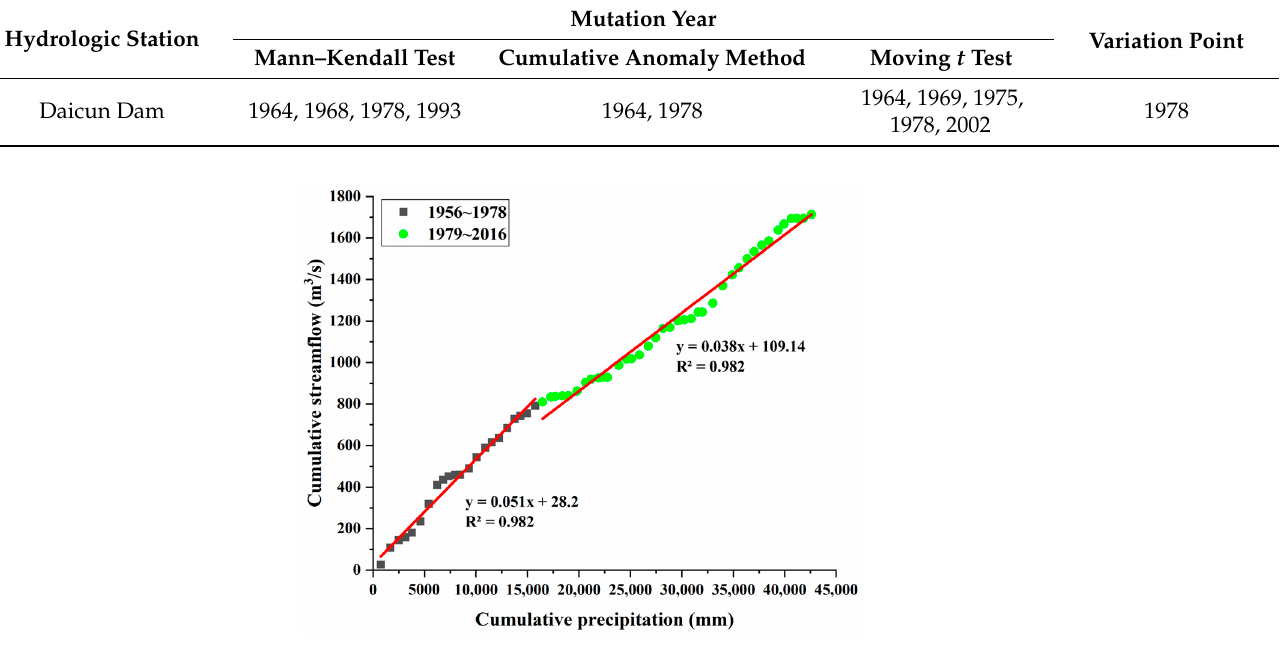
Figure 4. Precipitation–streamflow double-accumulative curve at Daicun Dam Hydrological Sta- tion. Table 2. Result of the mutation test of annual measured runoff of Dawen River.